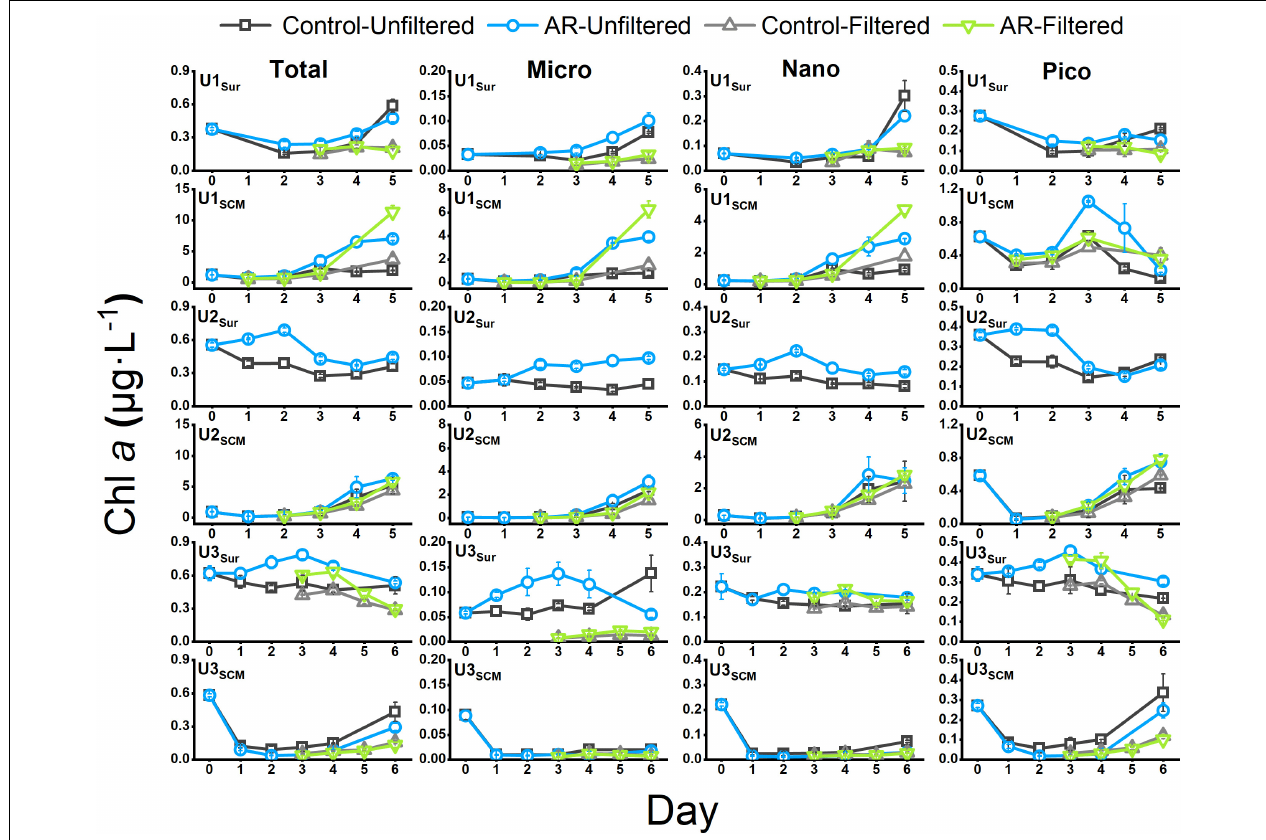
FIGURE 4 | The concentration of Chl a in the control and AR treatments incubated with surface and SCM seawaters. The error bar represents the standard deviation of three parallel samples.